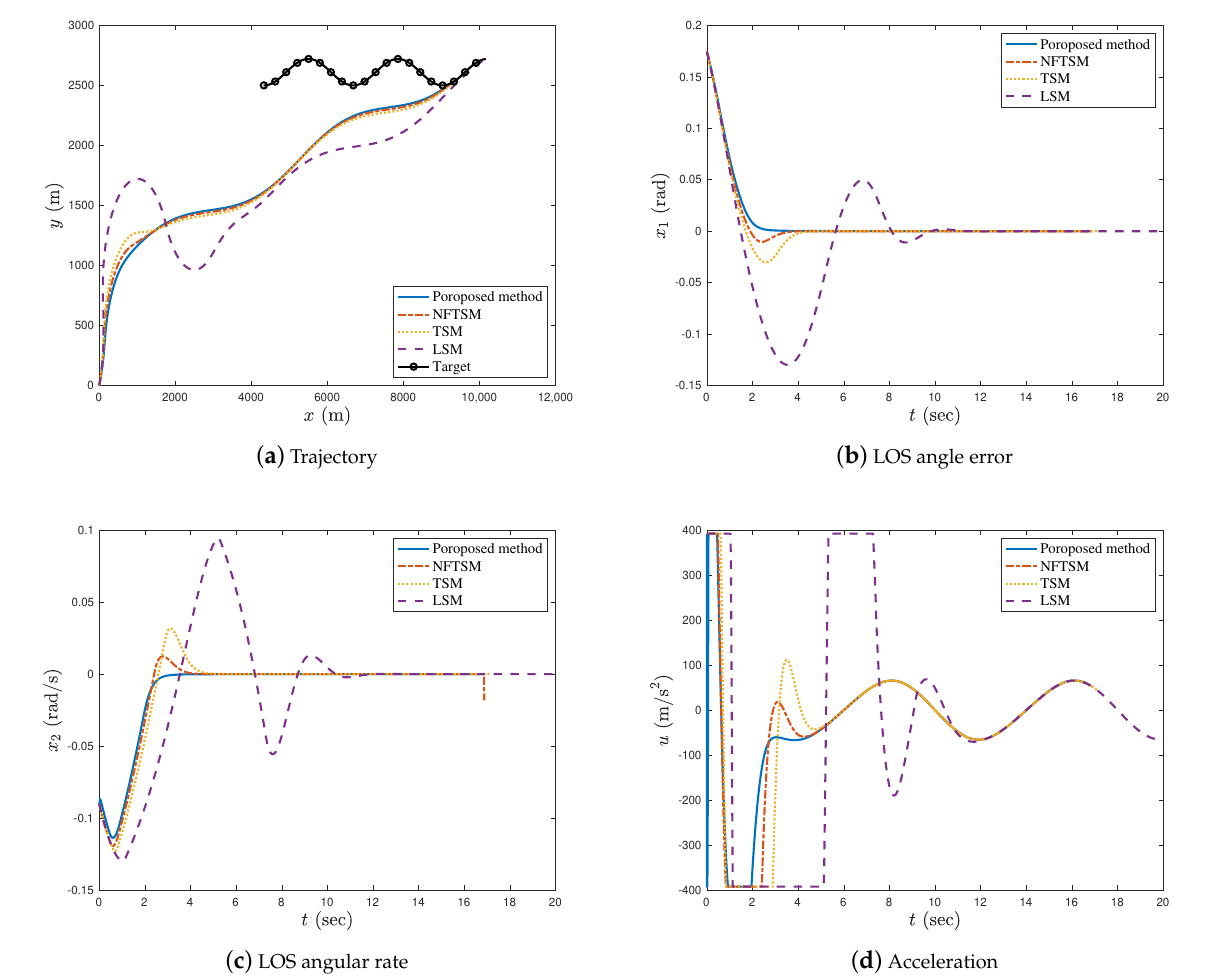
Figure 14. Comparison of the proposed method and the LSM, TSM, and NFTSM guidance laws. As shown in Figure 14a, it can be seen that the proposed fractional-order guidance law and the other three guidance laws based on integer-order sliding mode successfully intercepted a target. The convergence speed of the LOS angle error and LOS angular rate with the proposed guidance law were faster than those with the guidance laws based on integer-order sliding mode. As shown in Figure 14d, the accelerations of the missiles with the proposed guidance law and guidance laws based on integer sliding mode were all within a reasonable scope, but there was acceleration saturation when using the proposed method to achieve faster